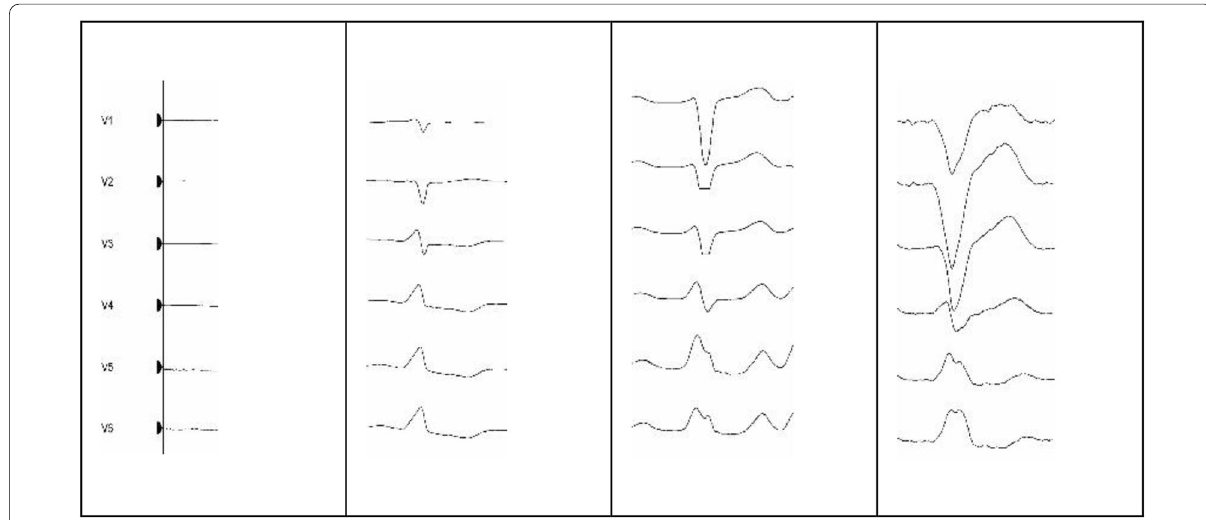
Fig. 3 ECG localization in the vertical plan of RVOT ectopies is based on the QRS morphology differences in precordial leads. A superior origin (left panel ECG) is characterised by r < S in V3, R > s in V4), a mid-origin is favoured by